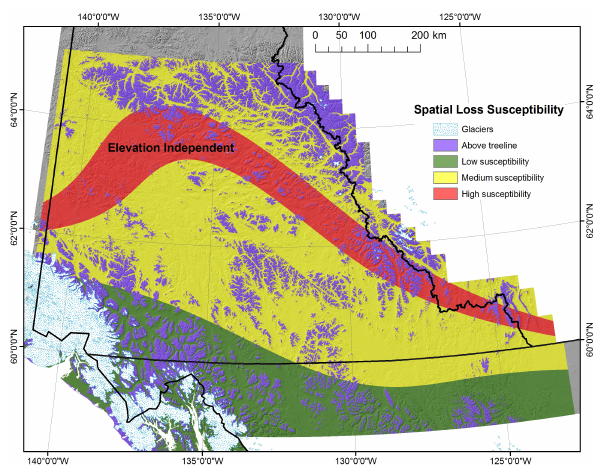
Fig. 15. Spatial loss susceptibility below treeline to small changes in MAAT (e.g. + 1K). Susceptibility is based on